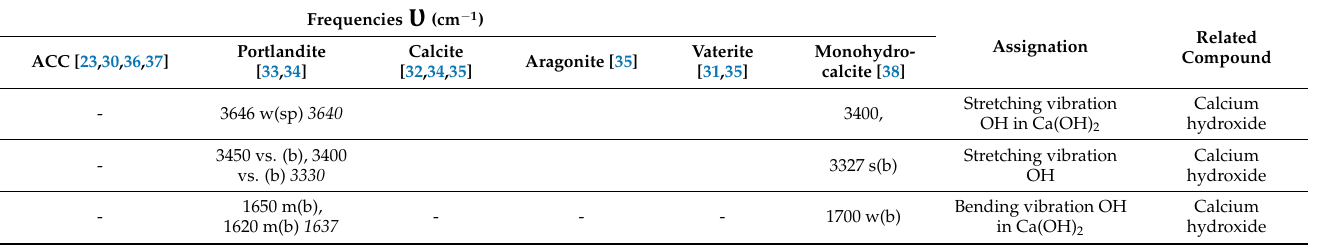
Table 4. Diagnostic IR band frequencies obtained in this study and from the literature [30–38].